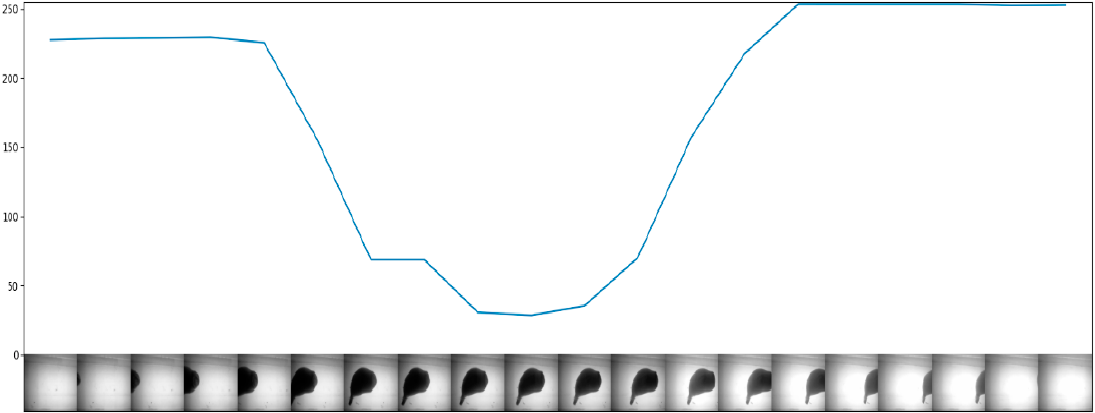
Figure 17. Relationship between the pixel mean value of the central area of the field of view and the position of garlic seeds.